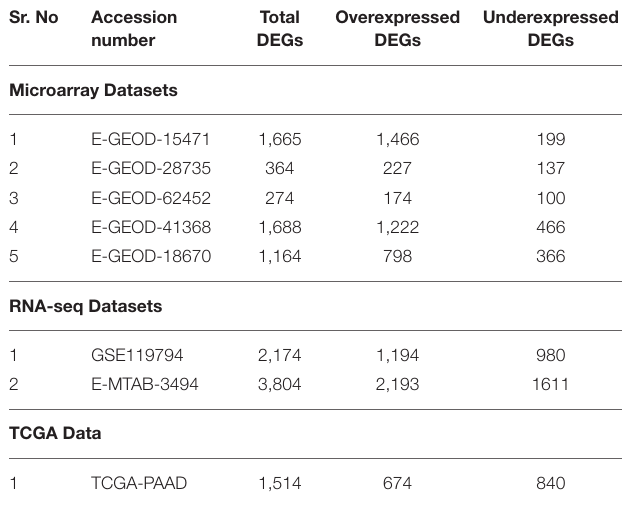
TABLE 3 | Total number of DEGs retrieved from all microarray and RNA-seq datasets are presented against the number of over and underexpressed genes are shown against each